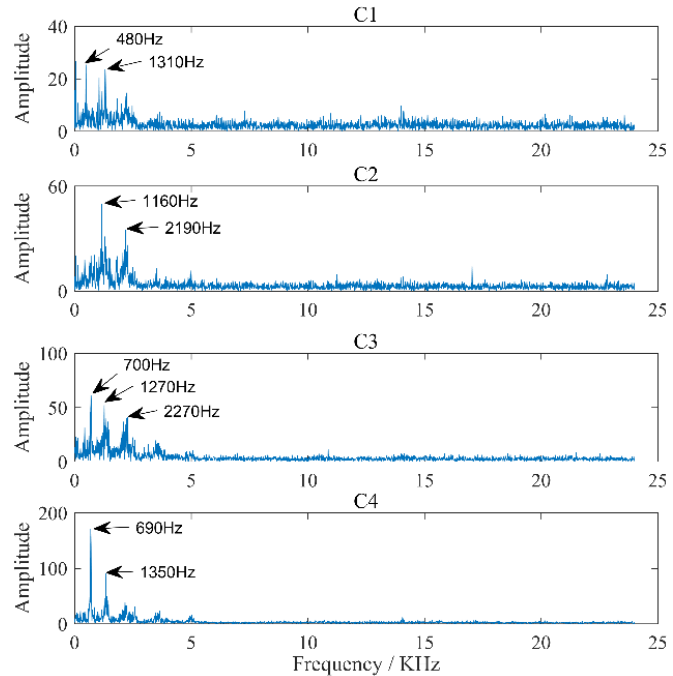
Figure 13. The spectrum of cutting the vibration signal.